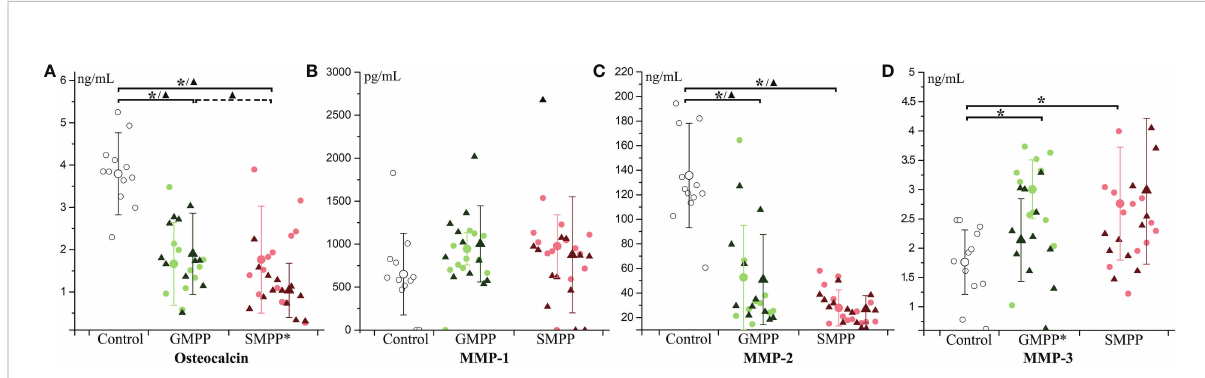
FIGURE 7 The level of Osteocalcin and matrix metalloproteinases (MMPs): (A) Osteocalcin; (B) MMP-1; (C) MMP-2; (D) MMP-3. Indications of groups and symbols are the same as described in Figure